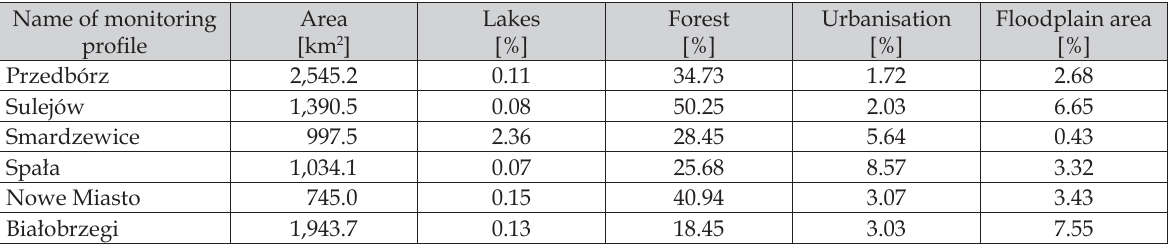
Table 3. Characteristic of the Pilica River sub-catchments land cover between individual monitoring profiles (calculated from CORINE–2006 and PGI 2007